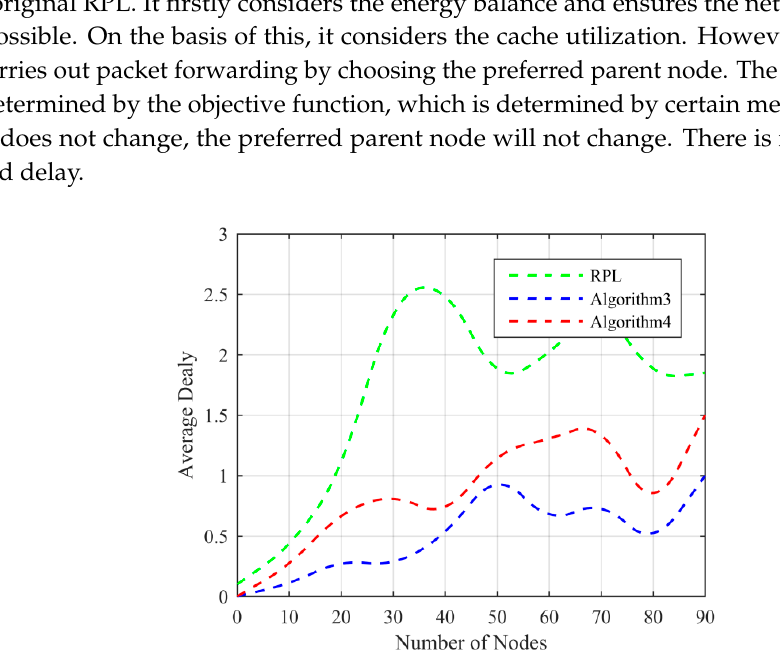
Figure 10. Network end-to-end delay in different size.